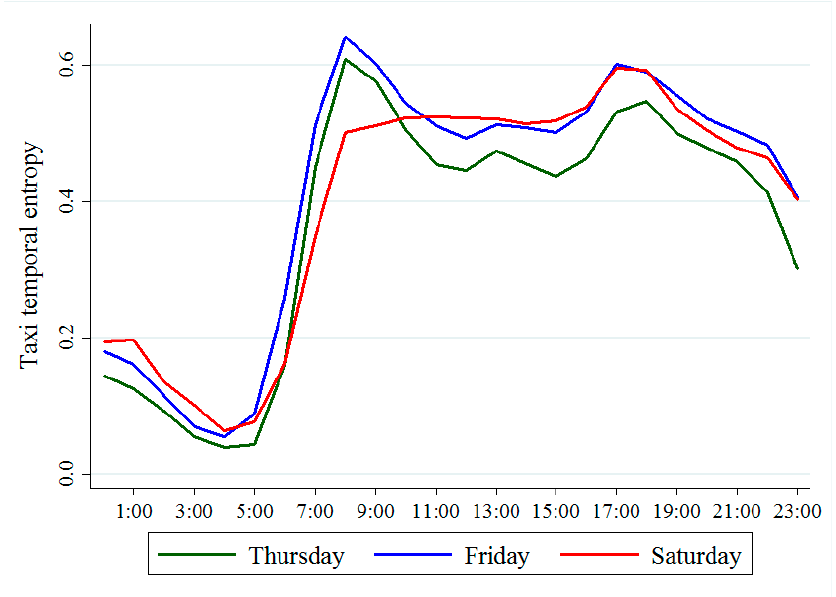
Figure 4. Distribution of taxi temporal entropy over time.